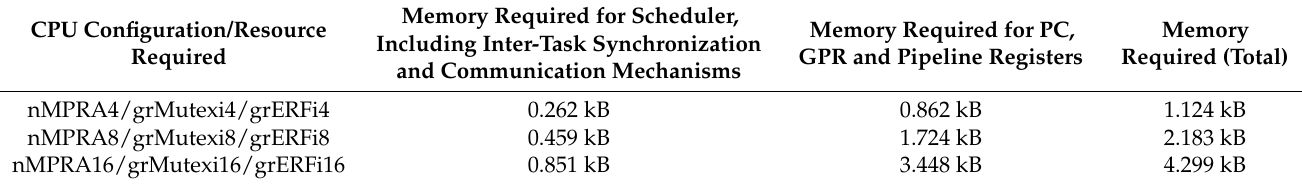
Table 2. Memory requirements for the datapath resource multiplication including real-time event handling unit.